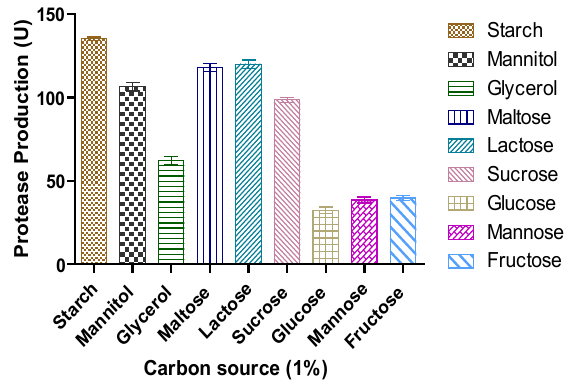
Fig. 1. Effect of different carbon sources on alkaline protease